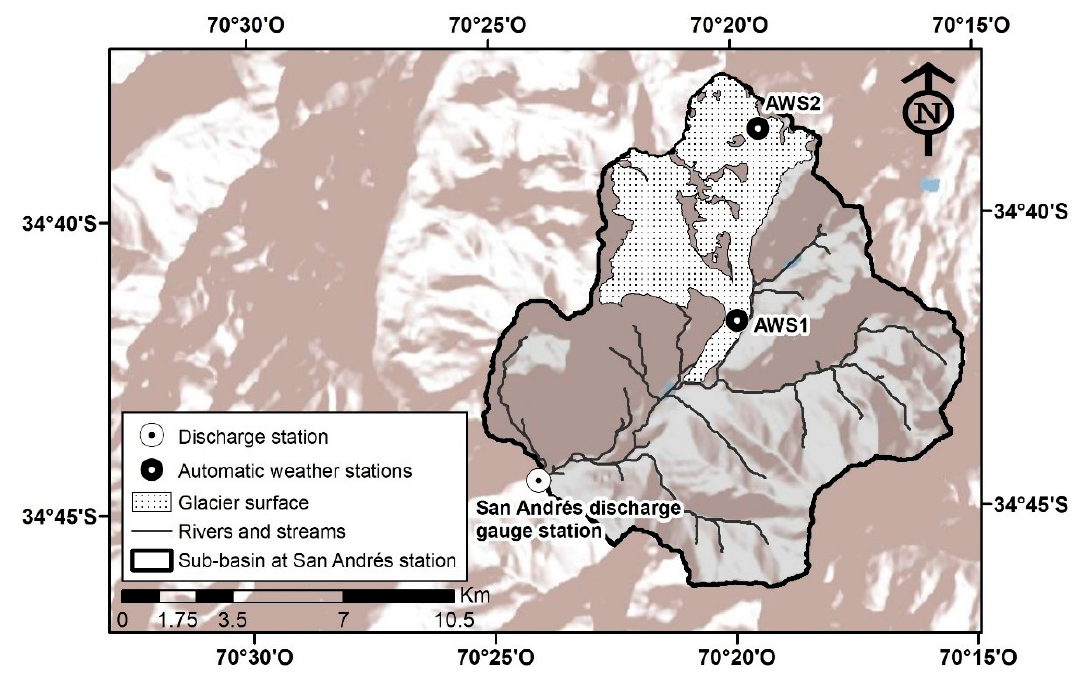
Figure 2. Delimitation of the sub-watershed upstream of the San Andrés discharge gauging station, as well the surface of Universidad Glacier, the water network and on-glacier automatic weather stations (AWS1 and AWS2).